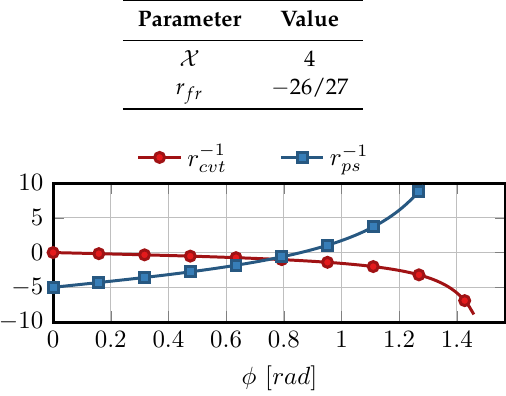
Table 1. Planetary gear and fixed ratio transmission ratios.